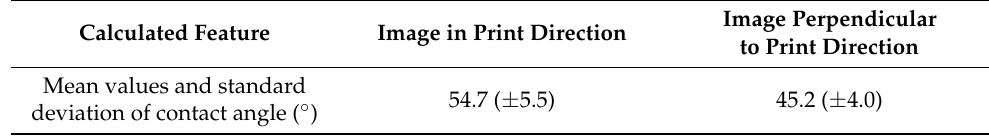
Table 5. Contact angle measurement results for sample—29—PJM, MED610